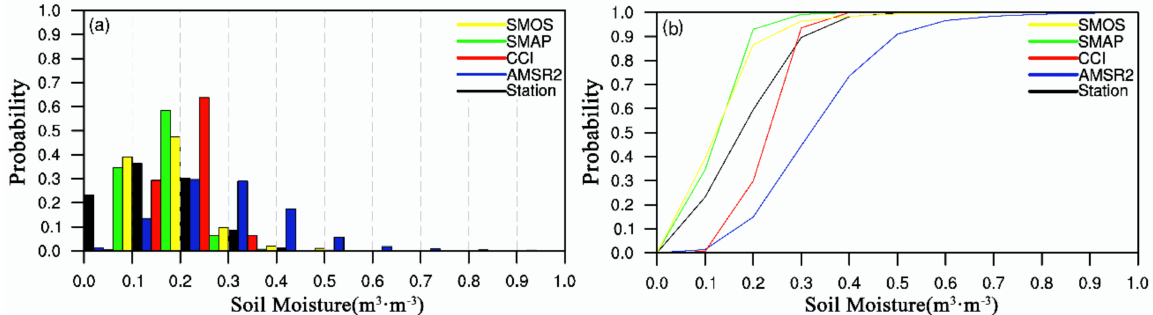
Figure 2. Probability distribution ( a ) and cumulative distribution function ( b ) of soil moisture observations and retrieved values of different soil moisture